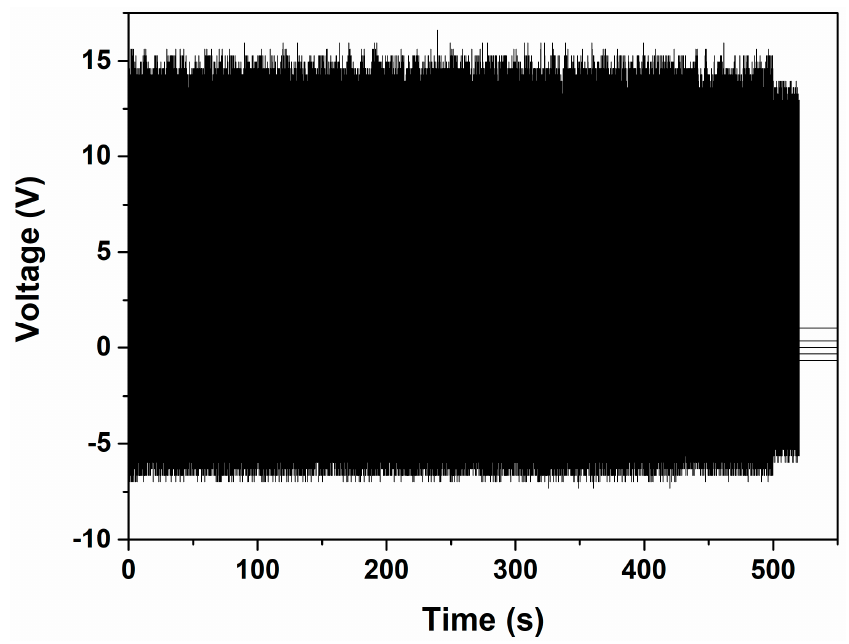
Figure 8. Fatigue tests on CNT-doped porous TENG.